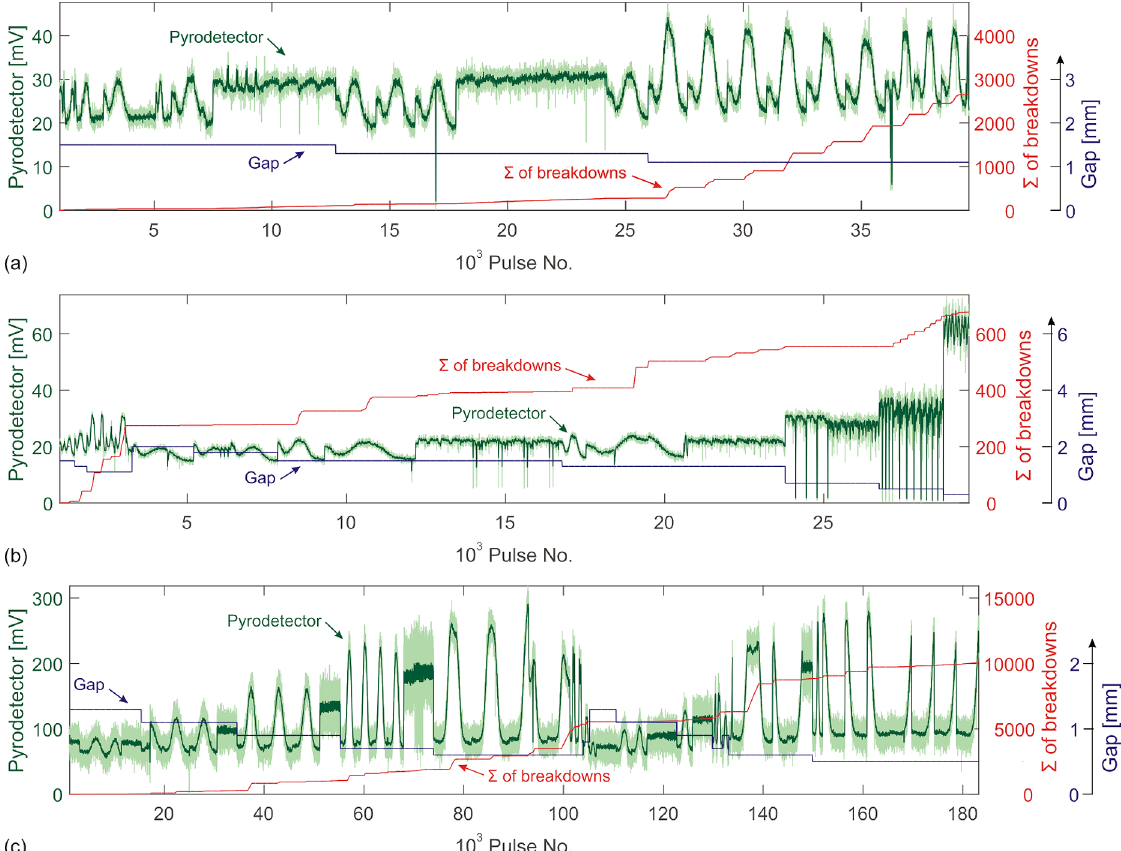
FIG. 14. Timeline of the experiments with the 200 GHz traveling-wave accelerating structures, copper structure with 3.2 nC of bunch ¼ 50 μ m (a),(b) and copper-silver structure with 1.6 nC of bunch charge and σ charge and σ z reference pyrodetector signal, the blue is the gap, and the red is the integrated number of breakdowns, recorded with the arc detector. Bell-shaped curves of the pyrodetector signal are generated during the scans of the beam over the cavities, and flat parts are the time intervals when we performed frequency measurements and collection of